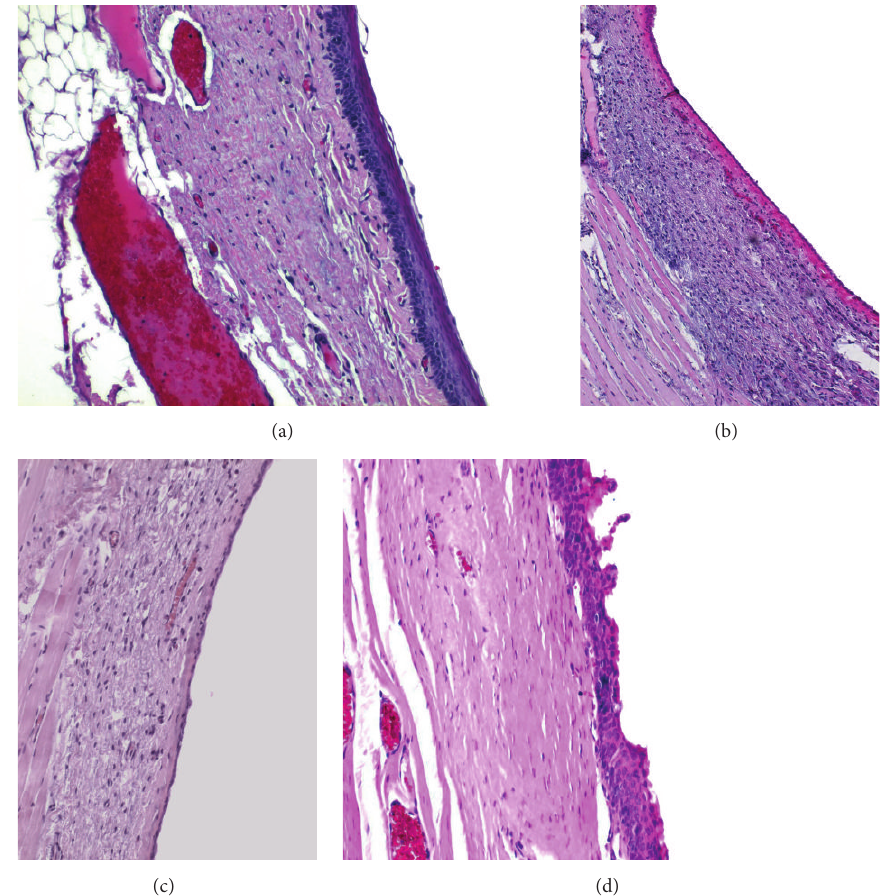
Figure 9: (a) Normal vocal fold. (b) Scarred vocal fold. (c) Injection of ADSC. (d) Injection of